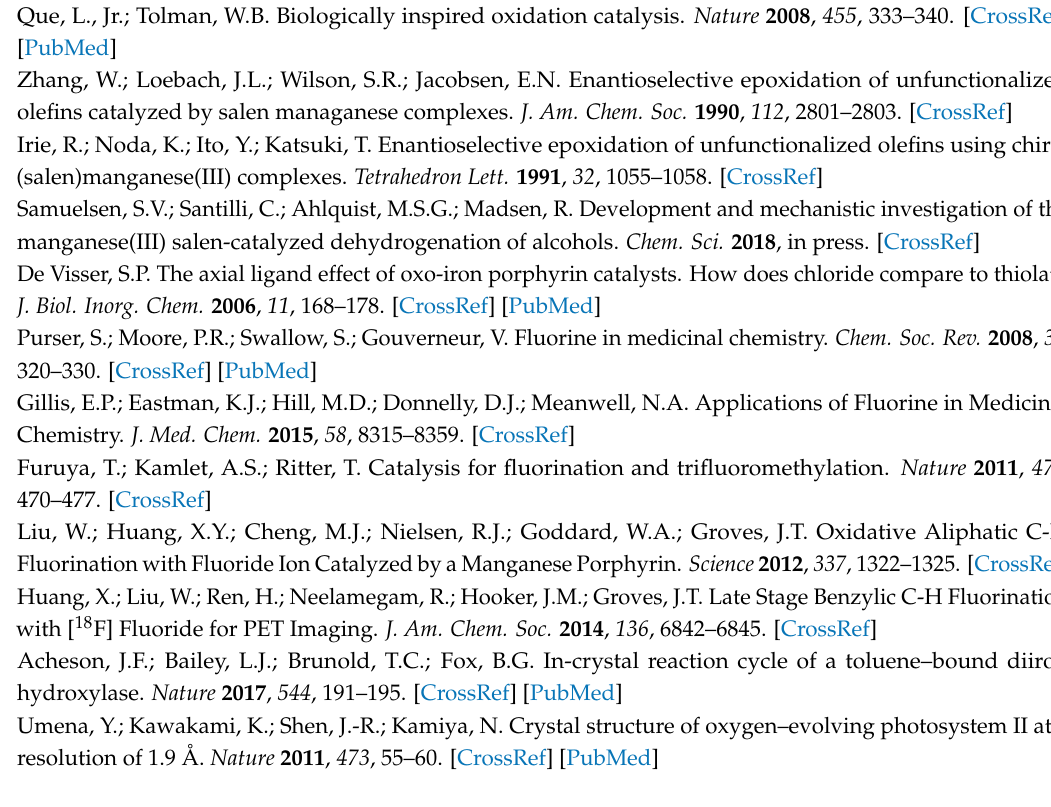
Supplementary Materials: The following are available online. Table S1: Compounds with charge, spin multiplicity used in training sets 1 and 2 for fluorine and chlorine, Figure S1: Illustration of the Mn and Fe complexes in Table S1, Table S2: List of names used in the test set to evaluate the performance on magnetic interactions, Figure S2: Illustration of local minima for EDEVIW optimized by UPM6, UrPM6, and UPM7, Table S3: Spin density distributions for stationary points obtained at the UB3LYP/SVP, UPM6, UrPM6, and UPM7 levels of theory. Author Contributions: T.S. conceived and designed the research, and drafted the manuscript; T.S. and M.F. performed the calculations and analyzed the data; T.S. and Y.T. reviewed and edited the manuscript. All authors discussed the results and commented on the